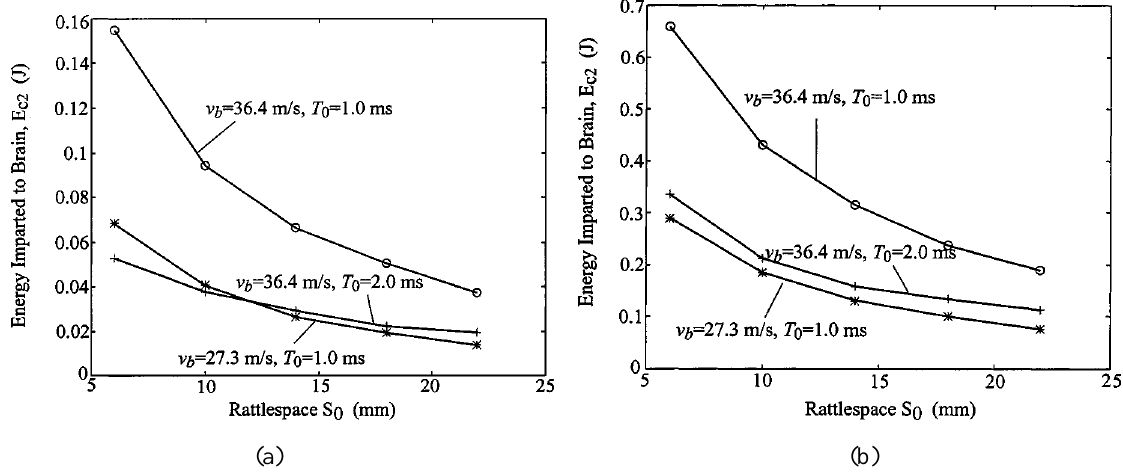
Fig. 15. The trade-off curves for Case 2 (minimization of the energy imparted to the brain): (a) Front impact: A–P direction, (b) Side impact: L–R